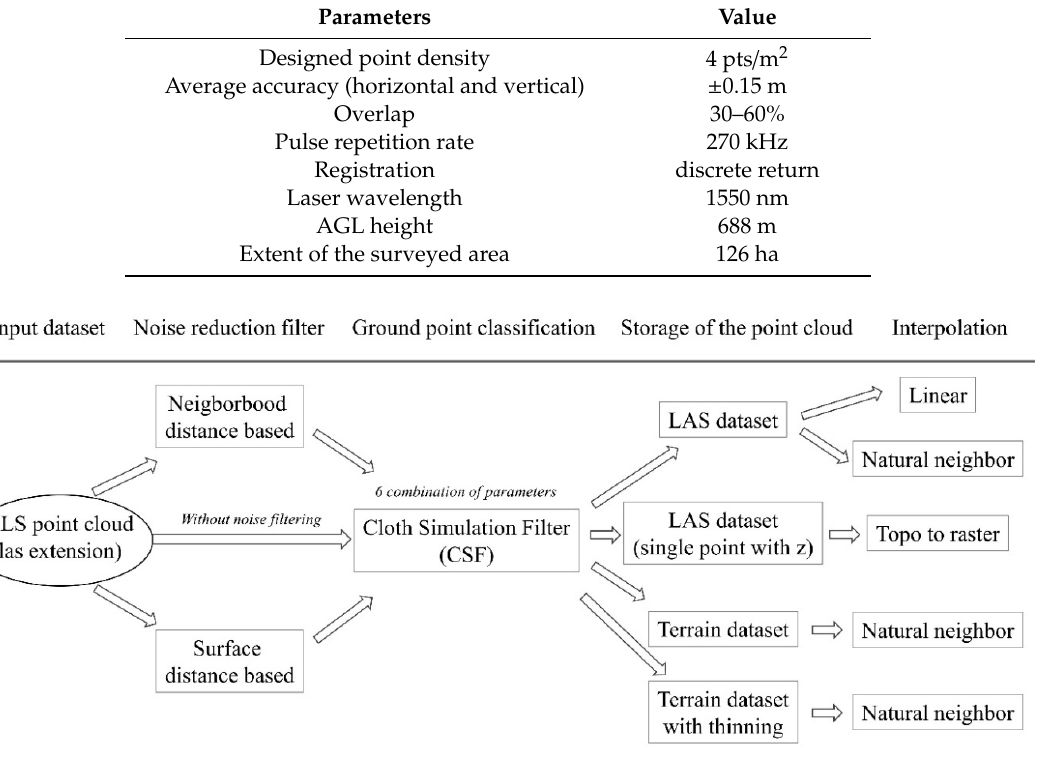
Figure 3. The workflow of the analysis (full factorial analysis in all possible combinations, altogether there were 180